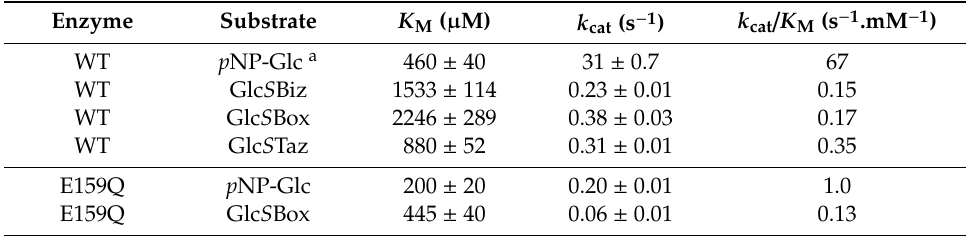
Table 2. Kinetic parameters of WT and acid / base E159Q mutant of Dt Gly. pNP-Glc hydrolysis activity was measured by p NP release quantification. Other substrate hydrolysis activities were determined by quantification of the released glucose. All experiments were done in three independent replicates and are expressed as Mean ± SD.